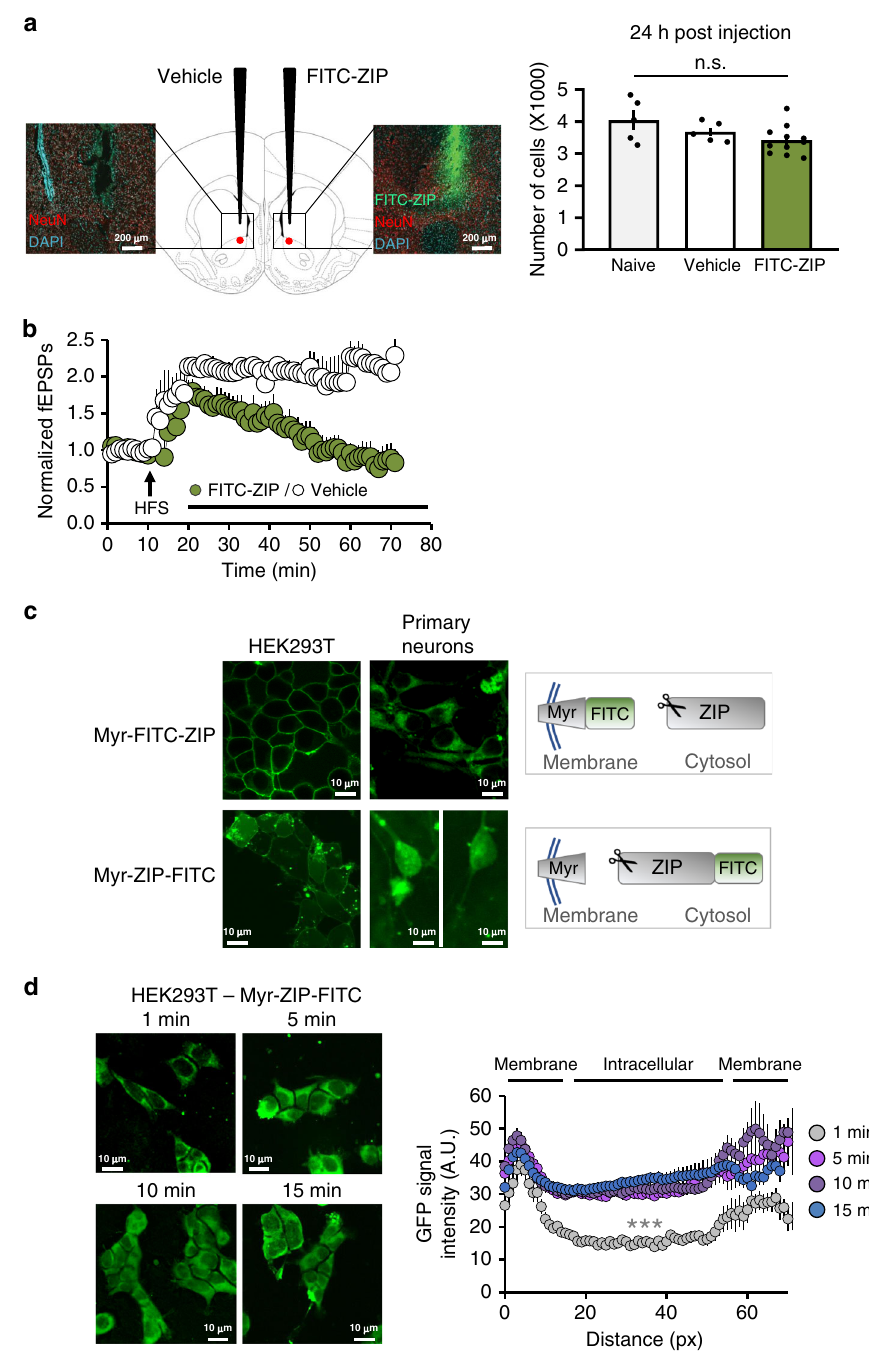
Fig. 3 ZIP is localized to the membrane in both HEK293 cells and primary cortical neurons. a Assessment of brain cell viability. FITC-ZIP (green, 1 mM) or vehicle were microinjected into the NAc of rats (AP + 1.75, ML ± 1.48, DV − 6.2). Twenty-four hour after injection, animals were sacri fi ced and brain slices containing the NAc were stained with NeuN (red) or DAPI (blue). Graph depicts the number of DAPI-stained cells mean ± SEM in non-injected ( N = 5), vehicle injected ( N = 5) and FITC-ZIP injected ( N = 11) brains. No signi fi cant difference was observed between groups ( F = 2.912, p = 0.0802, one-way ANOVA; naïve vs. vehicle p = 0.4740, Naïve vs. FITC-ZIP p = 0.0675, vehicle vs. FITC-ZIP p = 0.5843). b Measurements of FITC-ZIP activity and cellular- membrane localization. fEPSPs in NAc slices were monitored before and after high frequency stimulation (HFS; arrow) to induce LTP. FITC-ZIP (5 µ M) (green circles; N = 3, n = 4) or vehicle (white circles; N = 3, n = 3) were bath applied 10 min following application of HFS. Data presented using normalized values ± SEM. c Representative fl uorescent images visualized with confocal microscopy taken from HEK293 cells (left) or mouse embryonic primary cortical neurons (right; DIV7) incubated with FITC-ZIP (5 µ M, top; HEK293 N = 5, Neurons N = 5) or ZIP-FITC (5 µ M, bottom; HEK293 N = 4, Neurons N = 5) for 1 h. d HEK293 cells were incubated with ZIP-FITC (5 µ M) for the time indicated in the panel. Fluorescence was visualized with a confocal microscope. Graph depicts line scan of FITC signal intensity mean ± SEM (1 min, n = 13; 5 min, n = 12; 10 min, n = 11; 15 min, n = 12; F = 32.16, p < 0.0001, one-way ANOVA, followed by Tukey post hoc test for multiple comparisons, zero point vs. 5 min. *** p < 0.0001, zero point vs. 10 min. *** p < 0.0001, zero point vs. 15 min. *** p <